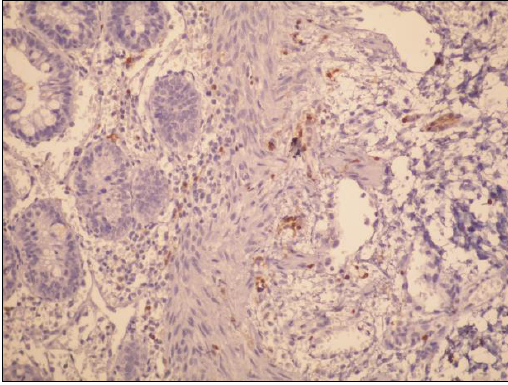
Figure 2: Diminished ganglions and neurons are highlighted by S-100 immunostaining in the sub- mucosa of the colon wall (immunoproxidase